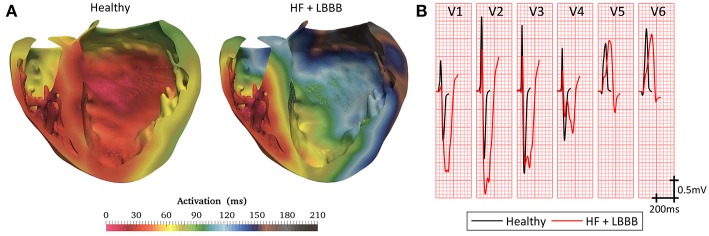
Model validation. (A) Cross section of biventricular model showing color coded local activation maps of a healthy (left) and pathological heartbeat (right). (B) Precordial leads signals recorded on torso surface.